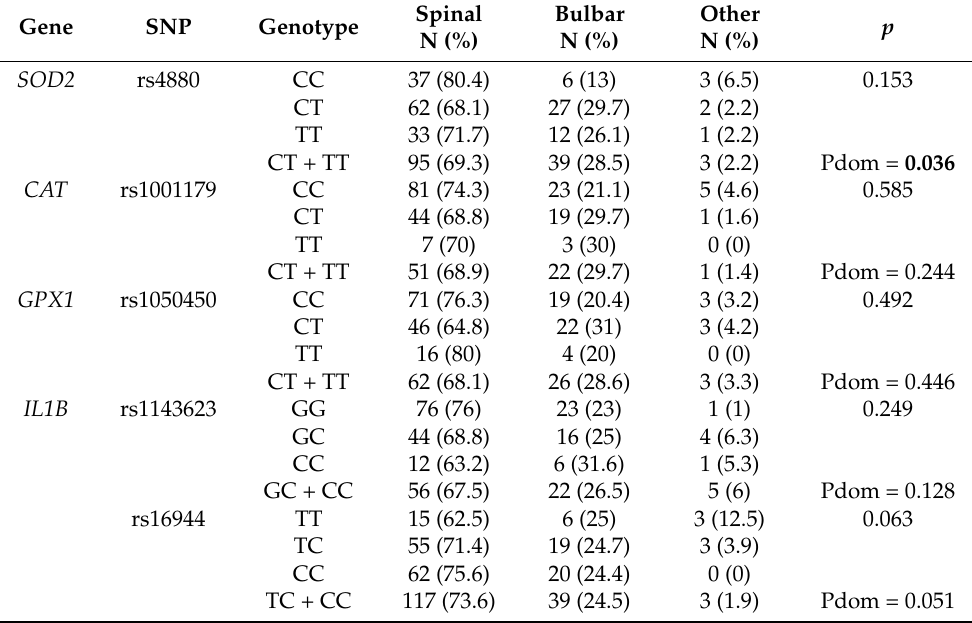
Table 3. Comparison of genotype frequencies among patients with different types of ALS